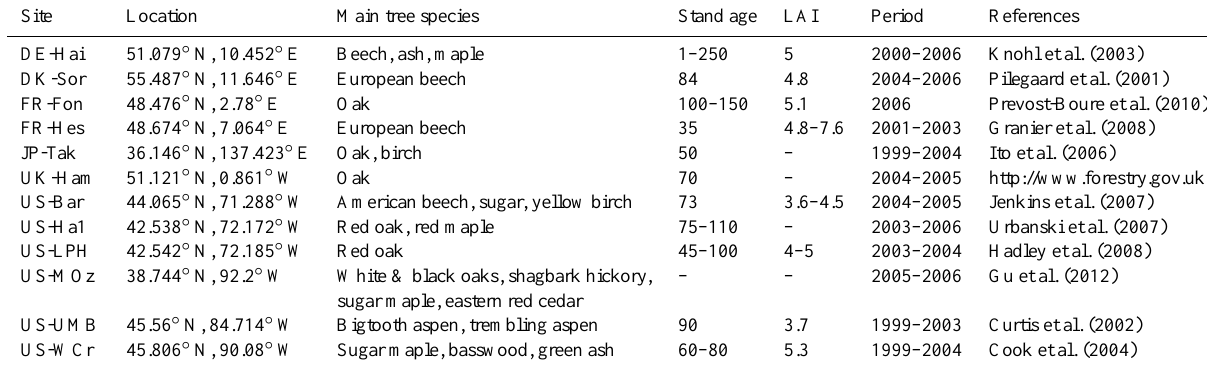
Table 1. List of the